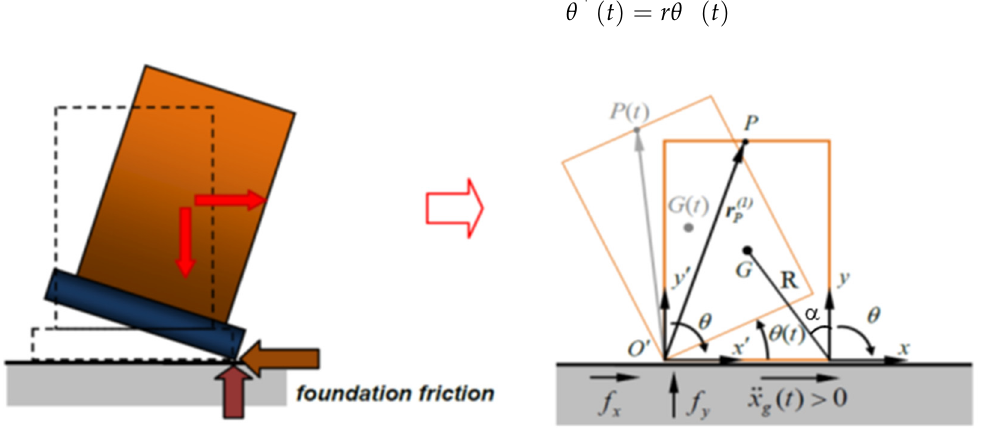
Figure 1. The rocking of construction ( left ) and Housner model ( right ).